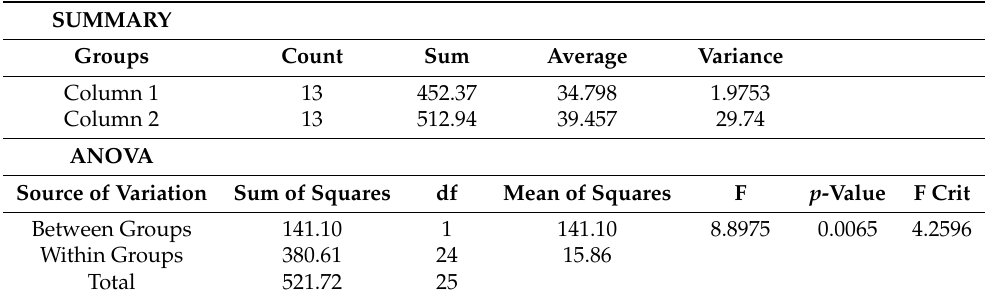
Table 6. Results of ANOVA-Single factor test, emphasizing the variance of γ LG in the two groups: γ LG determined in pendant drop model, and γ LG determined in contact angle model study at 25 ± 0.5 °C.